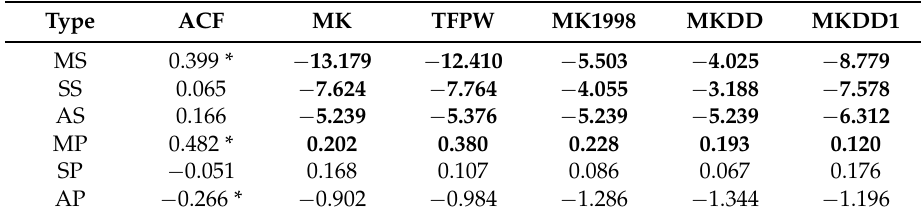
Table 1. Lag-1 autocorrelation functions (ACFs) and MK values (using different MK methods) of the original monthly, seasonal, and annual streamflow and precipitation series (MS: monthly streamflow; SS: seasonal streamflow; AS: annual streamflow; MP: monthly precipitation; SP: seasonal precipitation; AP: annual